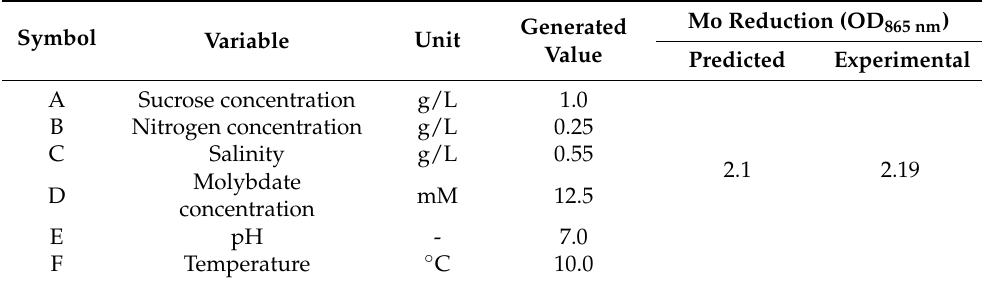
Table 3. Predicted and experimental value for Mo reduction using Arthrobacter sp. strain AQ5-05. Symbol